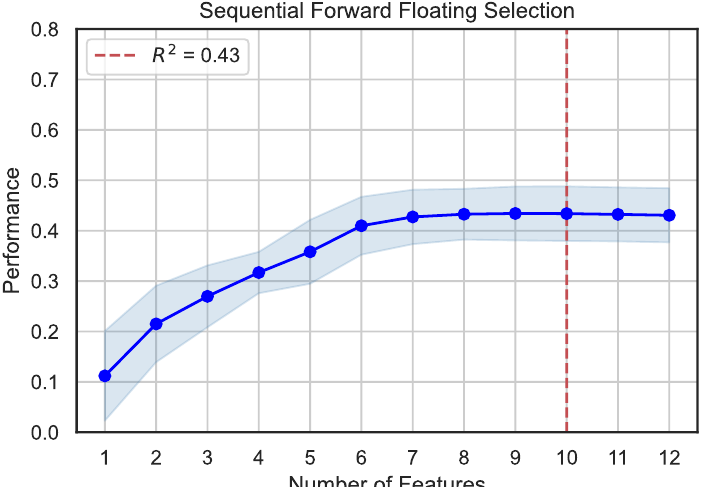
Figure 6. Model performance is shown for increasing numbers of features through successive iterations of our forward-floating sequential feature-selection scheme. The shaded region denotes ± 1 σ error from fold aggregation. The highest cross-validation performance was found for 10 features, although there was no increase in performance with increasing features, which plateaued after approximately seven features.